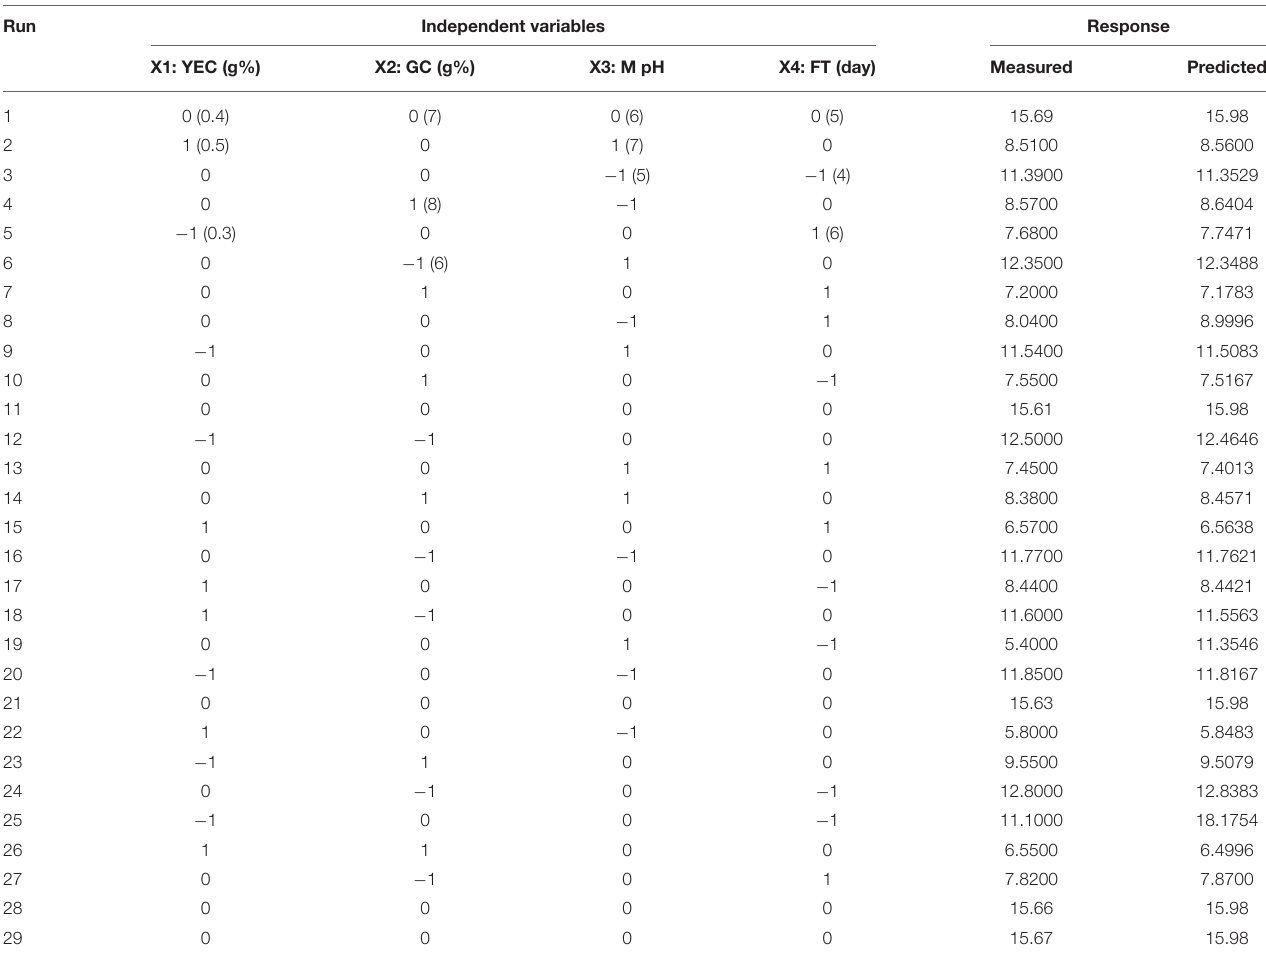
TABLE 4 | Experimental design with predicted and measured outcome of EPS yield using Box–Behnken design regarding C . alatae LCS1 fermentation system.